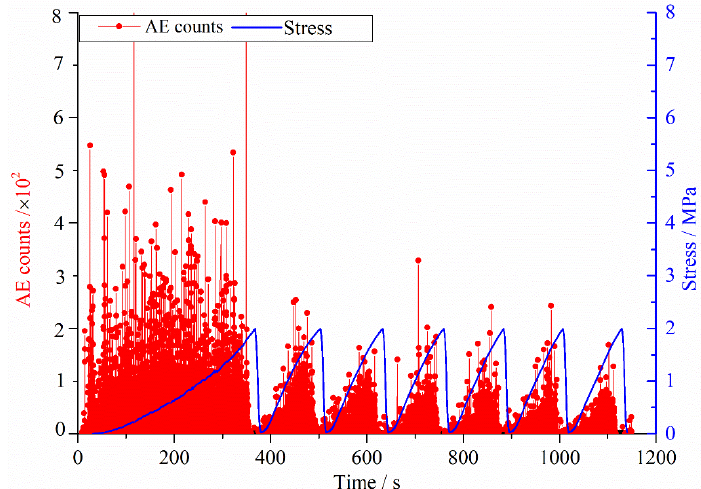
Figure 9. The evolution characteristics of AE counts under the CACL experiment. Minerals 2018 , 8 , x FOR PEER REVIEW